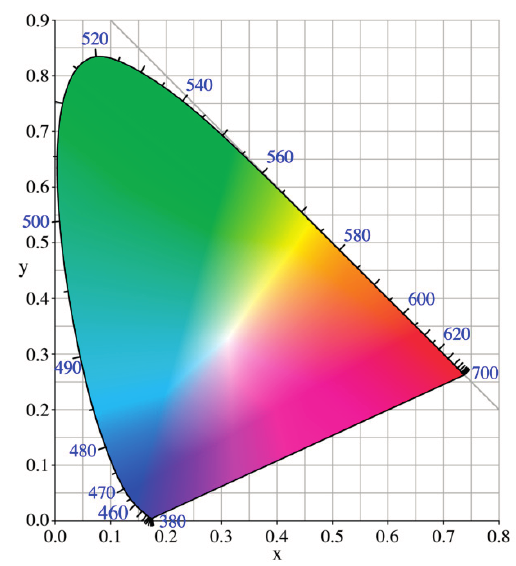
Figure 1. CIE 1931 chromaticity diagram.